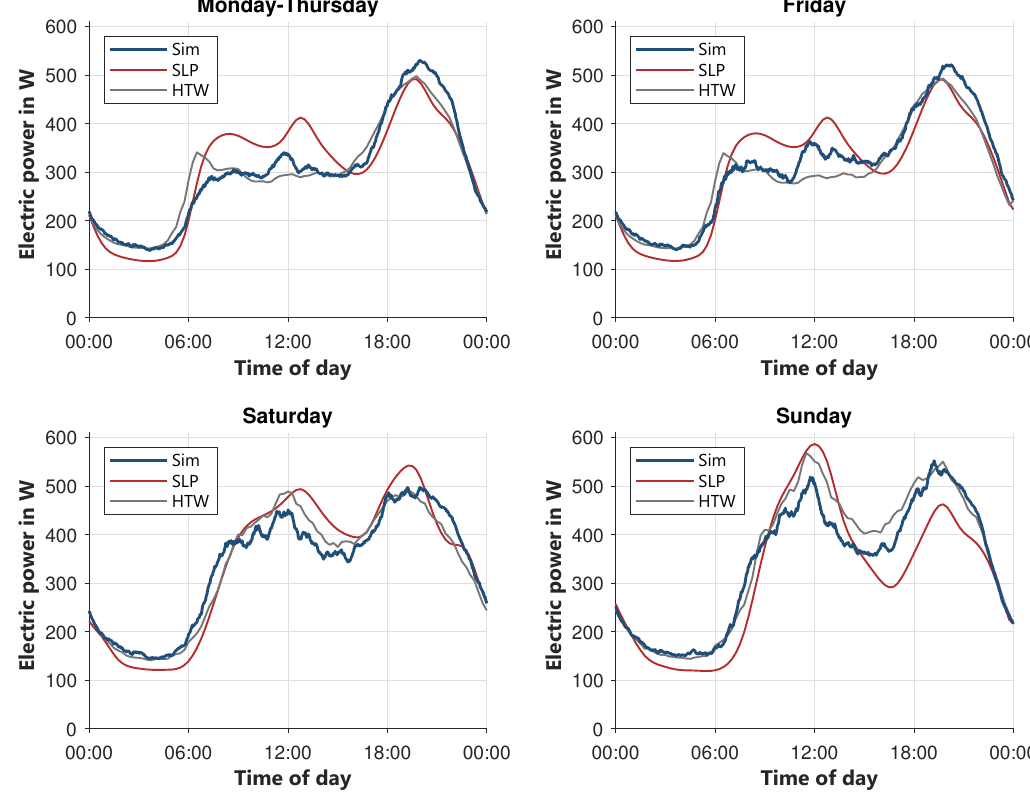
Figure 10. Comparison of average synthetic load profiles with standard load profiles and reference